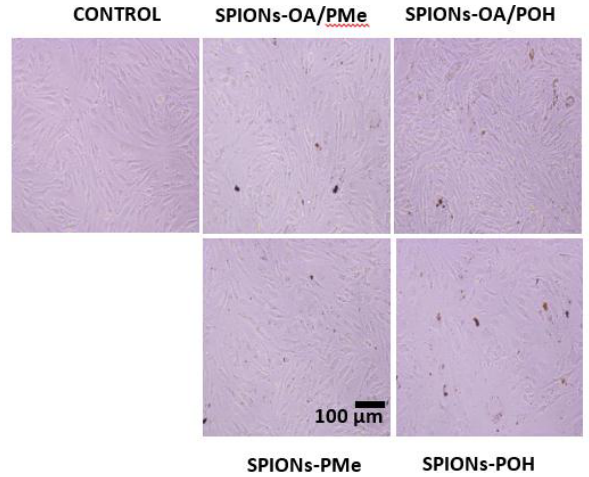
Figure 4. Optical images of bEnd.3 cells treated with 2.5 µg/mL of conjugated SPIONs for 24 h: Control, extreme left; SPIONs-OA/PMe, top middle; SPIONs-PMe, bottom middle; SPIONs-OA/POH, top extreme right; SPIONs-POH, bottom extreme right.